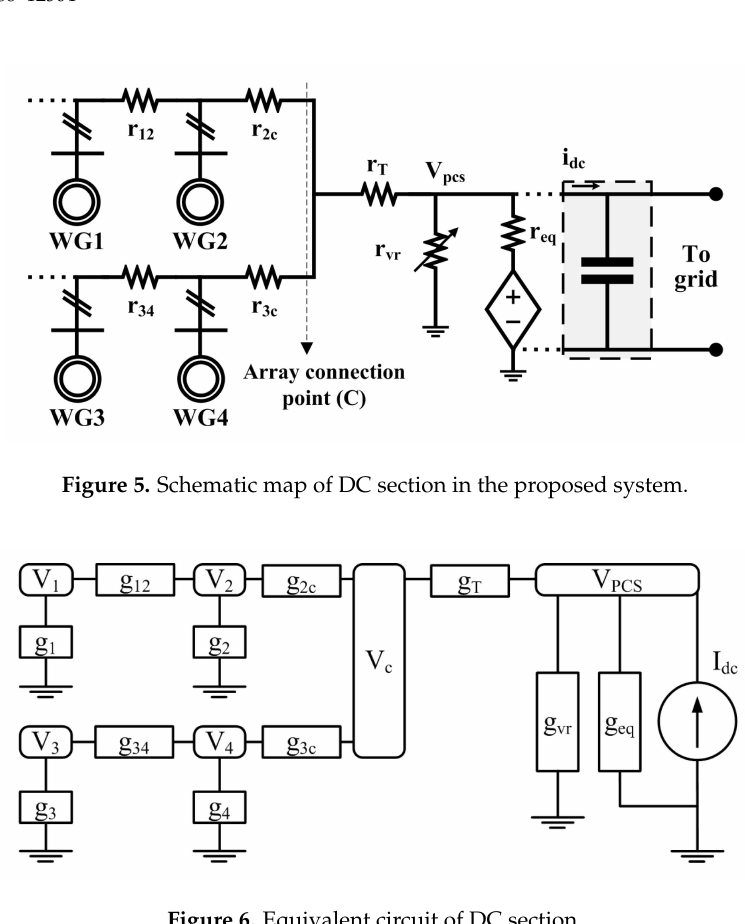
Figure 6. Equivalent circuit of DC